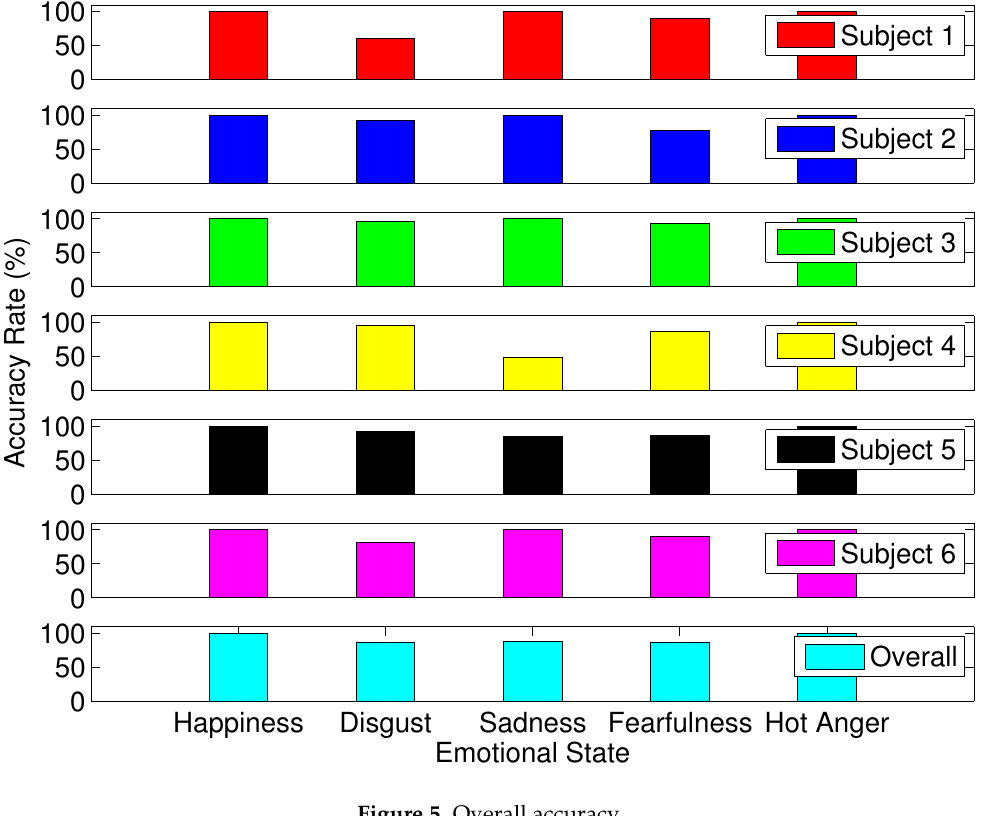
Figure 5. Overall accuracy. Table 3. The number of recognized emotional states and their proportions within the